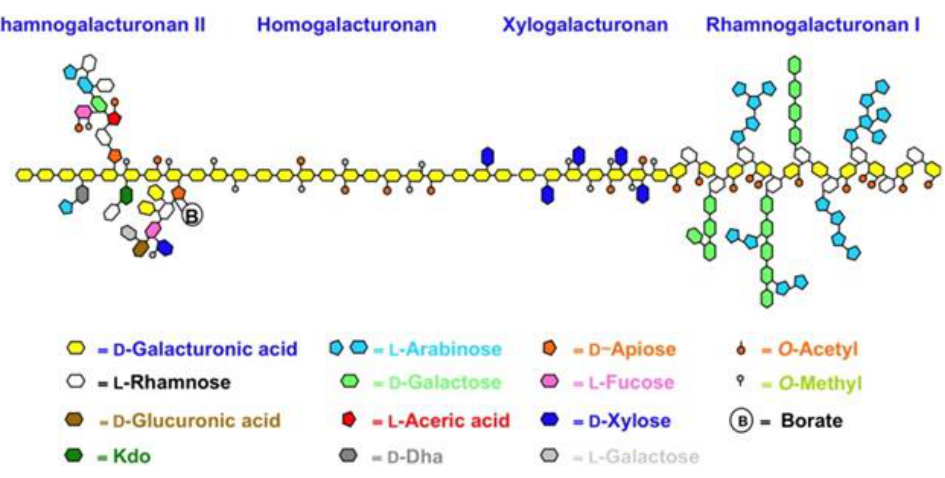
Table 1. Computed maximum ( 𝜈̃ , cm − 1 ), full width at half maximum (FWHM, cm − 1 ), relative area (A, %) and assignment of the bands obtained by decomposition into a sum of Gaussian compo- nents of the 1750 – 1500 cm − 1 region.